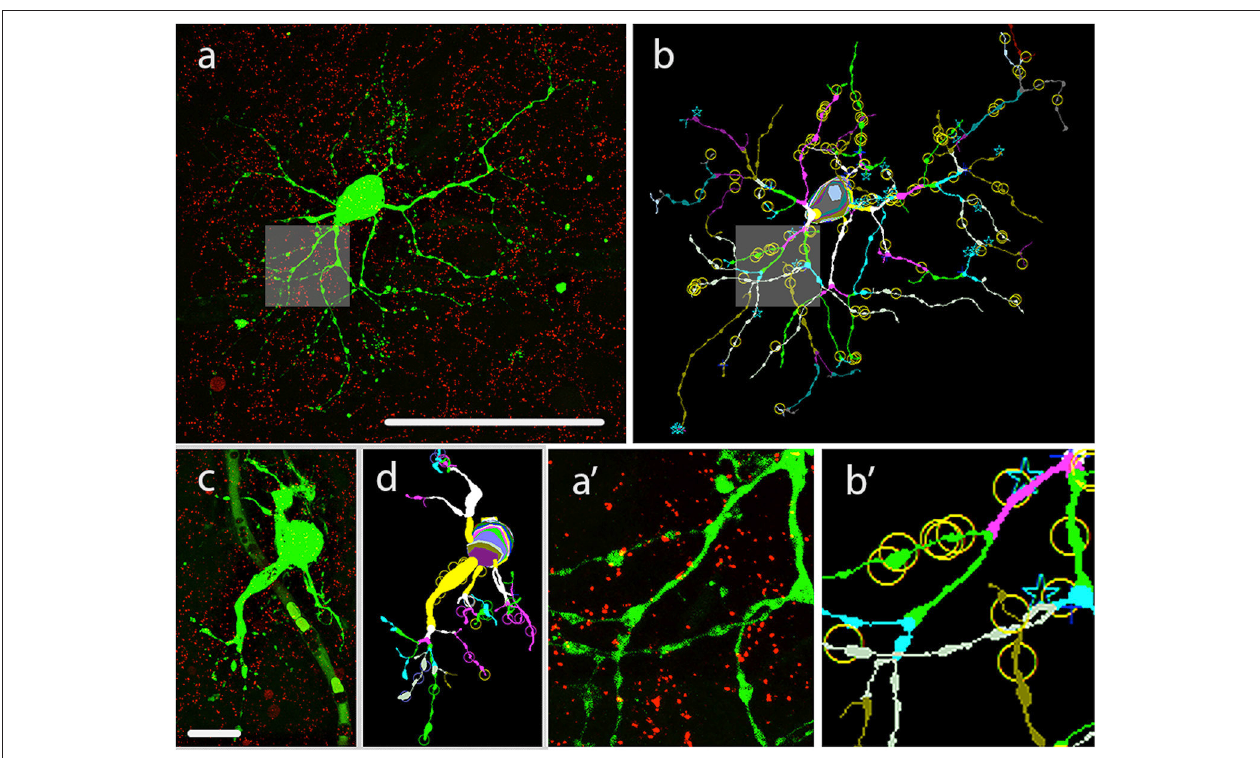
FIGURE 1 | LY injection, visualization and morphometric analysis of hRGCs . (a) Dual stained specimen in the human retina, displays a LY injected hRGC (green) with M cell-like soma-dendritic morphology and Cx36 plaque counter labels (red). Shadings in this image and also in (b) mark areas enlarged in insets (a ′ ,b ′ ) . (b) The NeuroLucida reconstruction of the cell in panel a depicts the dendritic structure by marking same order dendritic segments with uniform colors. This reconstruction also points out the locations of Cx36 plaques (circles,stars over the dendrites) that were found in colocalization with a dendritic segment of the LY labeled hRGC. (a ′ ,b ′ ) Insets display enlarged area of the LY labeled cell in (a ′ ,b ′ ) . (c,d) LY injected small hRGC with P cell-like morphology (c) and the Neurolucida reconstruction of the same cell (d) . Scale bar: 100 µ